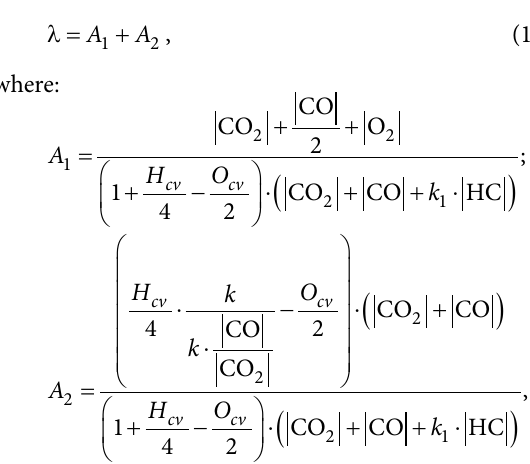
Fig. 6. CO emission versus time for petrol fuel (air conditioning unit is turned off)